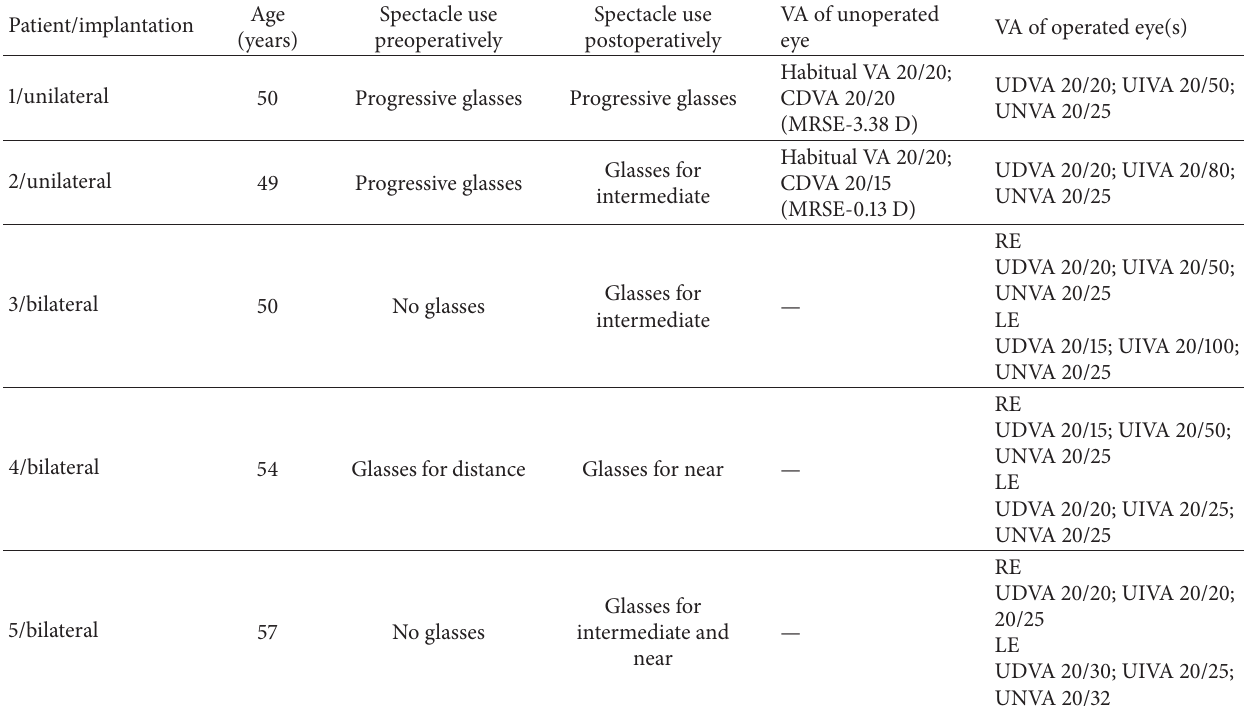
Table 4: Status of patients who reported spectacle use